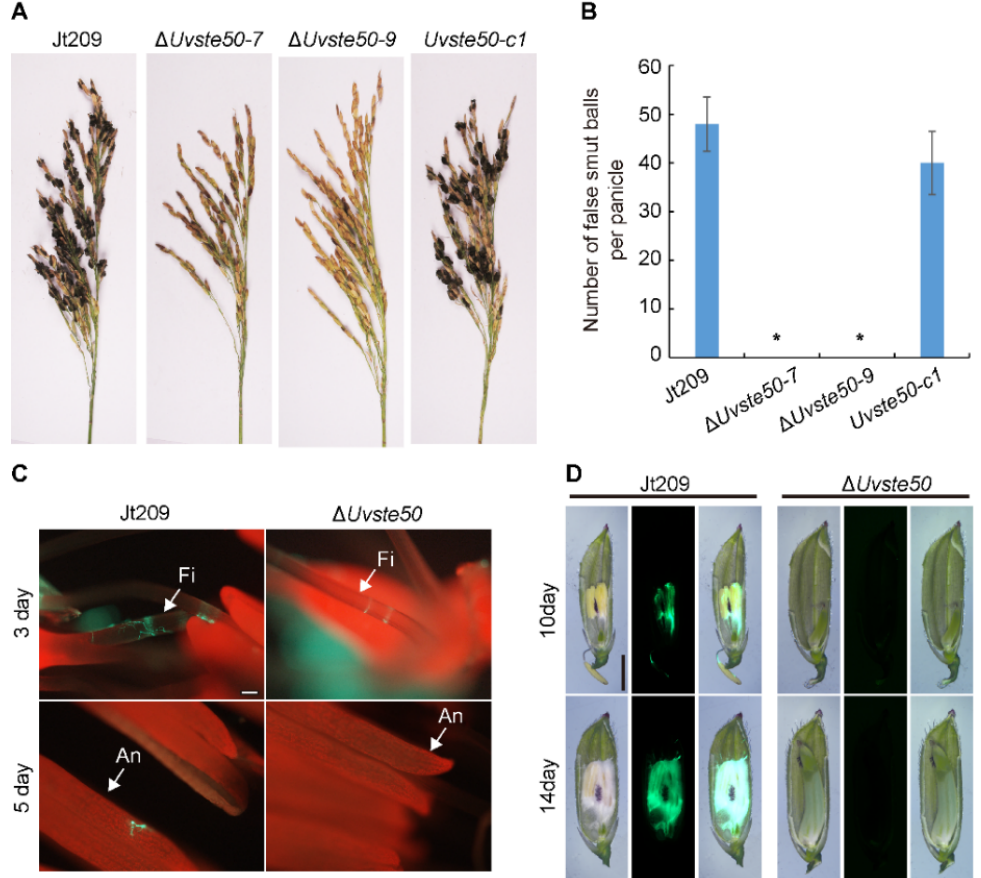
Figure 3. Virulence assay and infection development of Δ Uvste50 mutant on rice panicles. ( A ) Virulence of the wild ‐ type strain Jt209, the Δ Uvste50 mutant, and its complemented strain Uvste50 ‐ c at 30 days post ‐ inoculation (dpi) on susceptible rice cultivar Liangyoupeijiu. ( B ) Average number of false smut balls per panicle. Data were collected from three independent experiments. * represent significant differences between the Δ Uvste50 mutant and the wild ‐ type/complemented strains, analyzed by Duncan’s new multiple range test ( p < 0.05). ( C ) Mycelial extension of GFP ‐ tagged Jt209 and Δ Uvste50 on the inner floral organs at 3 and 5 dpi. Bar, 20 μ m. ( D ) Mycelial extension of GFP ‐ tagged Jt209 and ∆ Uvste50 inside the spikelets at 10 and 14 dpi. Bar, 10 µ